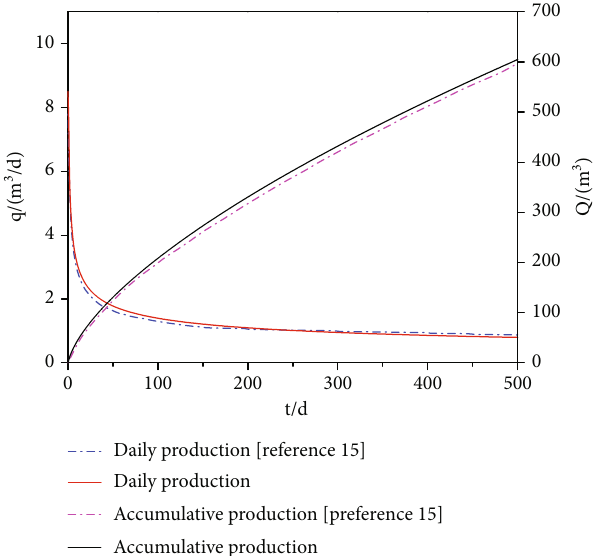
Figure 3: Comparison of production predicted curves between proposed model and reference